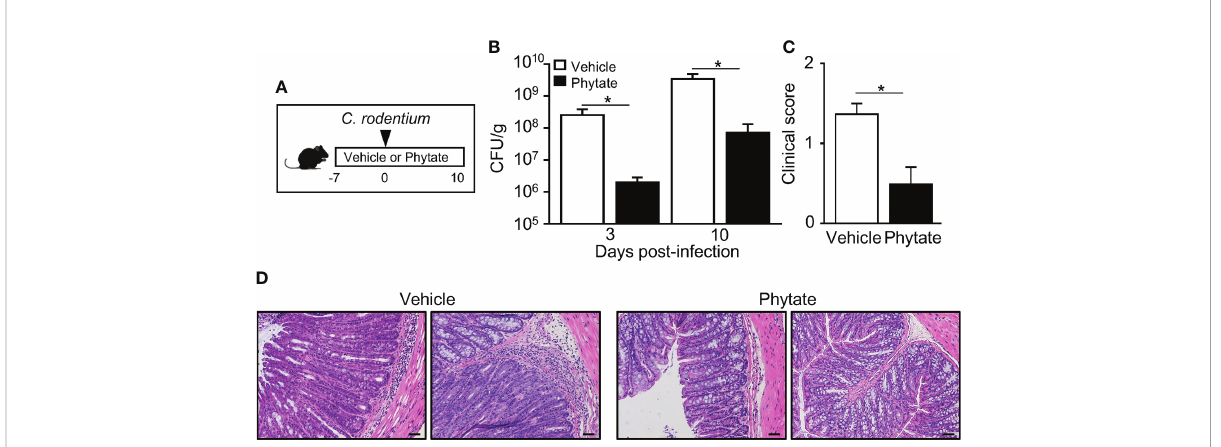
FIGURE 2 The natural component phytate in rice bran protects mice against C. rodentium . (A) Experimental approach. (B) CFUs of C. rodentium in stool of infected vehicle- or 2% phytate-treated mice, normalized to sample weight, days 3 and 10 post-infection. (C) Clinical scores representing severity of diarrhea, day 10 post-infection. (D) Histological staining of colon tissues of infected mice, day 10 post-infection. Scale bars: 10 m m. Data are representative of 2-3 independent experiments. n=4 per group. Results are mean ± SEM. * p <